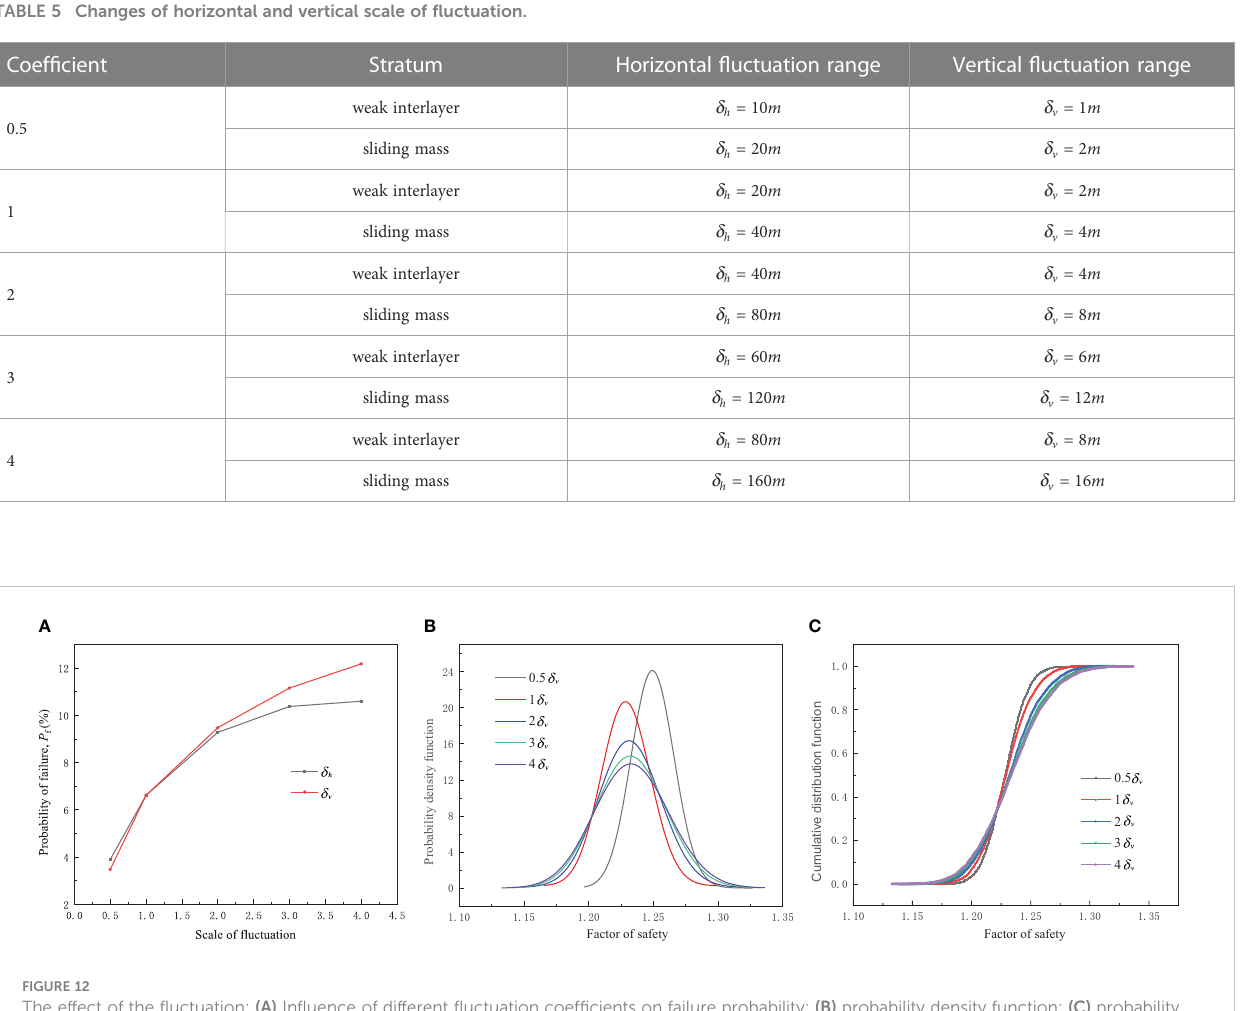
TABLE 5 Changes of horizontal and vertical scale of fl